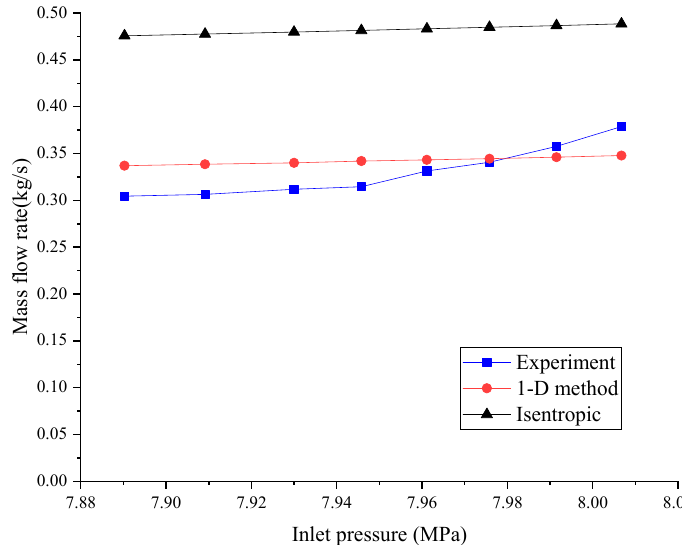
Figure 21. The comparison of 1-D method, isentropic model, experimental results.